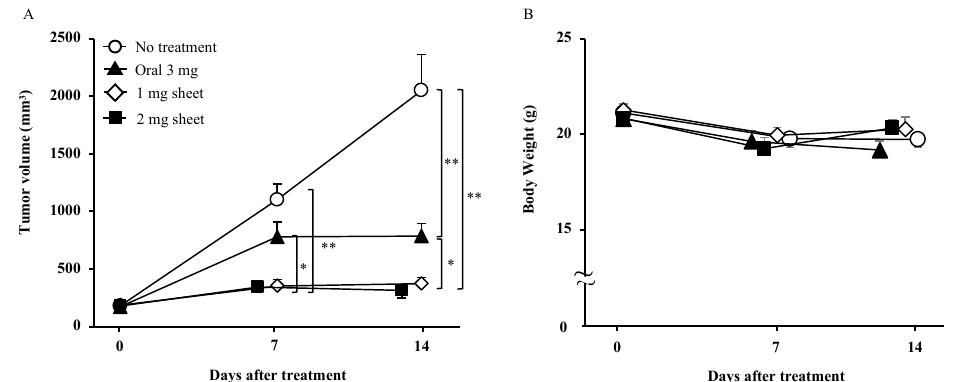
Figure 3. Antitumor effect of lenvatinib sheets in a subcutaneous tumor model. In total, 5 × 10 6 HuH-7 cells were subcutaneously transplanted into BALB/c nude mice. The mice were categorized into four groups according to the treatment: the no treatment (open circle; day 0: n = 28, day 7: n = 16, and day 14: n = 18), oral (filled triangles; day 0: n = 20, day 7: n = 10, and day 14: n = 10), 1 mg sheet (open diamond shape; day 0: n = 30, day 7: n = 15, and day 14: n = 20), and 2 mg sheet (filled square; day 0: n = 20, day 7: n = 10, and day 14: n = 10) groups. ( A ) Time course of xenograft tumor volume. ( B ) Body weight in each group. Data are presented as means ± standard deviations. The p -values between the indicated groups are presented as * p < 0.05 and ** p < 0.01. The results are the sum of three independent experiments. Table 2. Tumor volume and markers of liver injury in the serum.